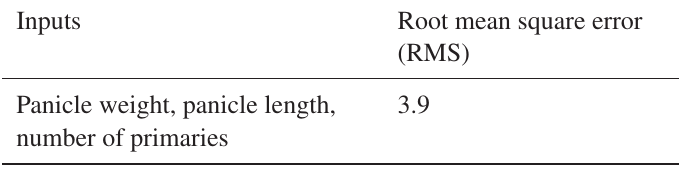
Table 3. Prediction results of three-to-one